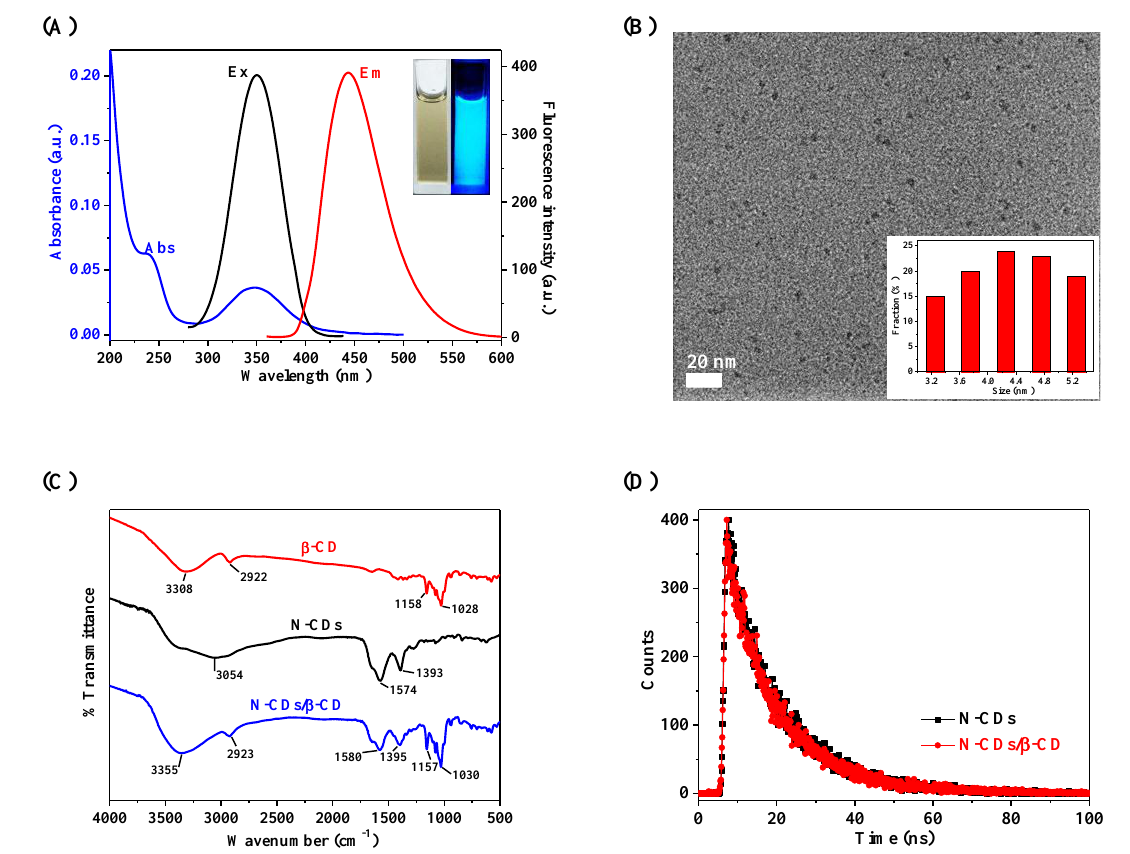
Figure 1. ( A ) UV-vis absorption spectra of N-CDs, excitation spectrum of N-CDs at λ em = 443 nm and emission spectrum of N-CDs at λ ex = 350 nm. Insert: Photograph of N-CDs under the radiation of white light (Left) and 365 nm UV lamp (Right); ( B ) HR-TEM image of N-CDs. Insert: Diameter size distribution curve of N-CDs; ( C ) FT-IR spectrum of N-CDs, β -CD and N-CDs/ β -CD nanocomposites; ( D ) Fluorescence decay traces of N-CDs without and with β -CD at λ ex/em = 350 nm/443 nm. N-CDs/ β -CD nanocomposites were firstly identified by FT-IR spectrometry. As shown